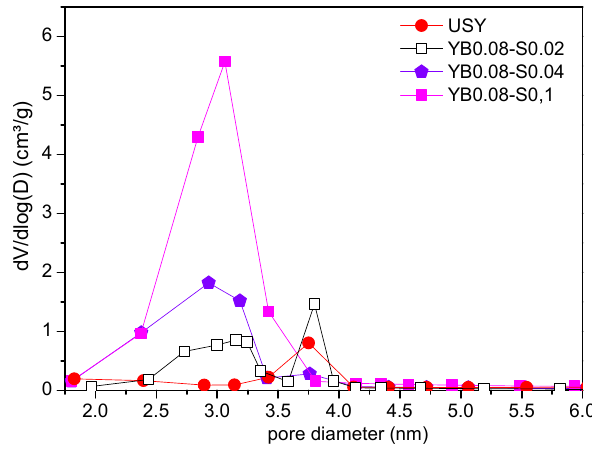
Figure 5. Pore diameter distributions (Barret-Joiner-Halenda method; BJH) of the modified zeolites produced using different CTAB concentrations.